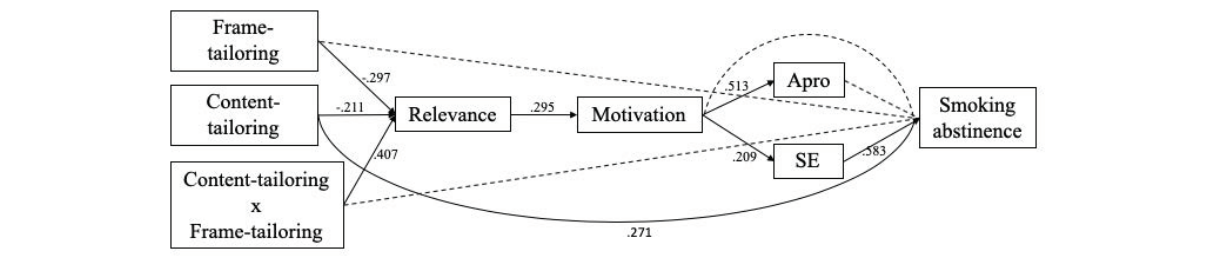
Figure 3. Final model with significant paths only. Results are presented as standardized direct effects. Dotted lines represent nonsignificant paths. Straight lines represent significant paths ( P &lt;.05). Apro, pros of smoking cessation; SE,